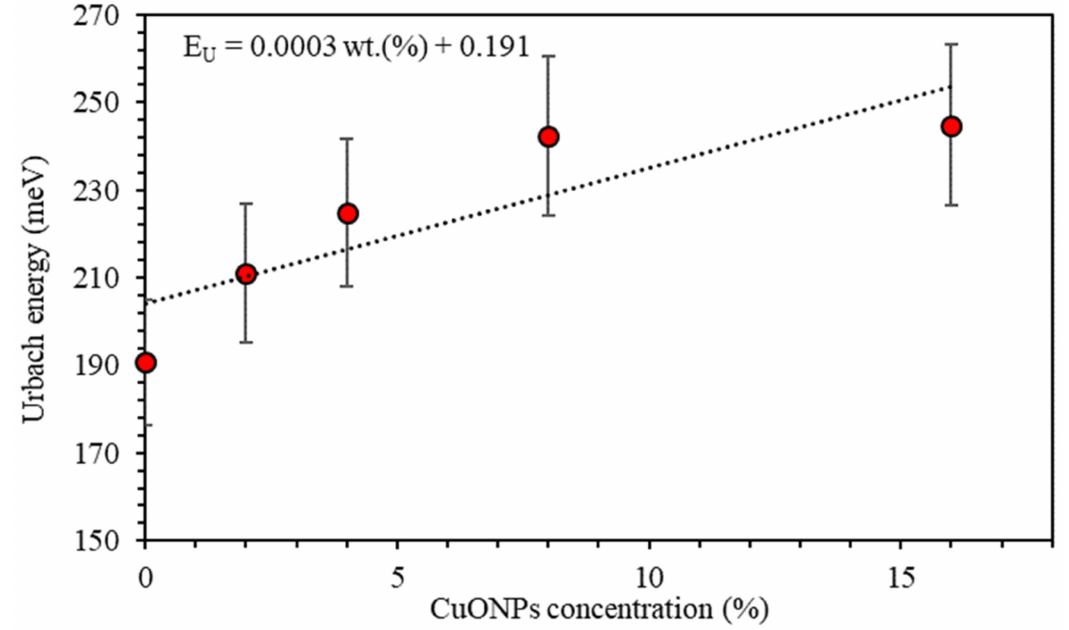
Figure 9. Urbach energy versus the concentration of CuO NPs in the PMMA–PVA/CuO nanocomposite thin